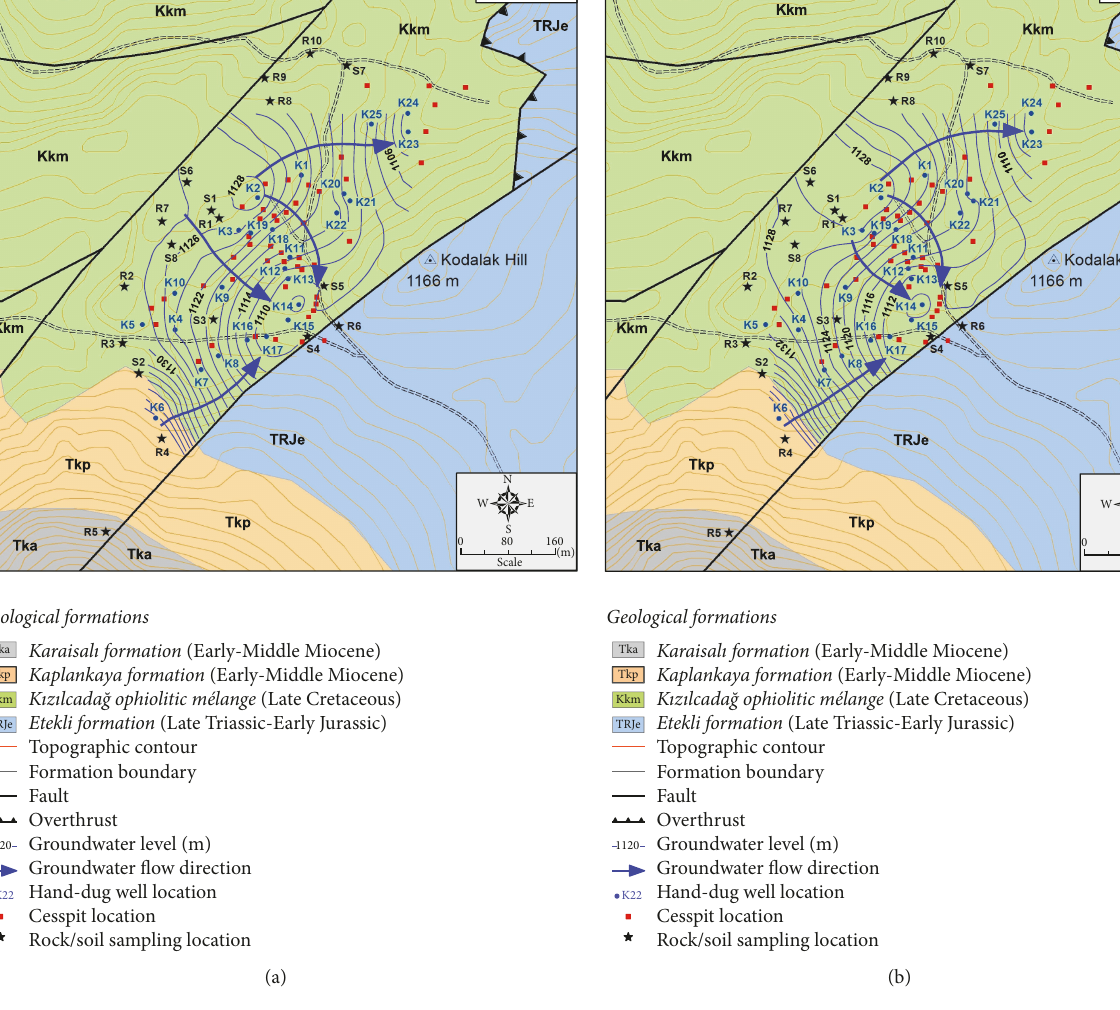
Figure 4: Hydrogeological map of the Kızılgedik study area (see red box in Figure 3(a)) showing locations of groundwater ( 𝑛 = 25 ), rock ( 𝑛 = 10 ), and soil ( 𝑛 = 8 ) sampling sites. The hand-dug well (HDW) codes (i.e., K1–K25) refer to both water table measurement and groundwater sampling sites. The water table elevations are given at intervals of 2m above mean sea level (msl) for both (a) dry season (October 2011) and (b) wet season (May 2012). Arrows depict the general direction of shallow groundwater flow in the fractured ophiolitic complex